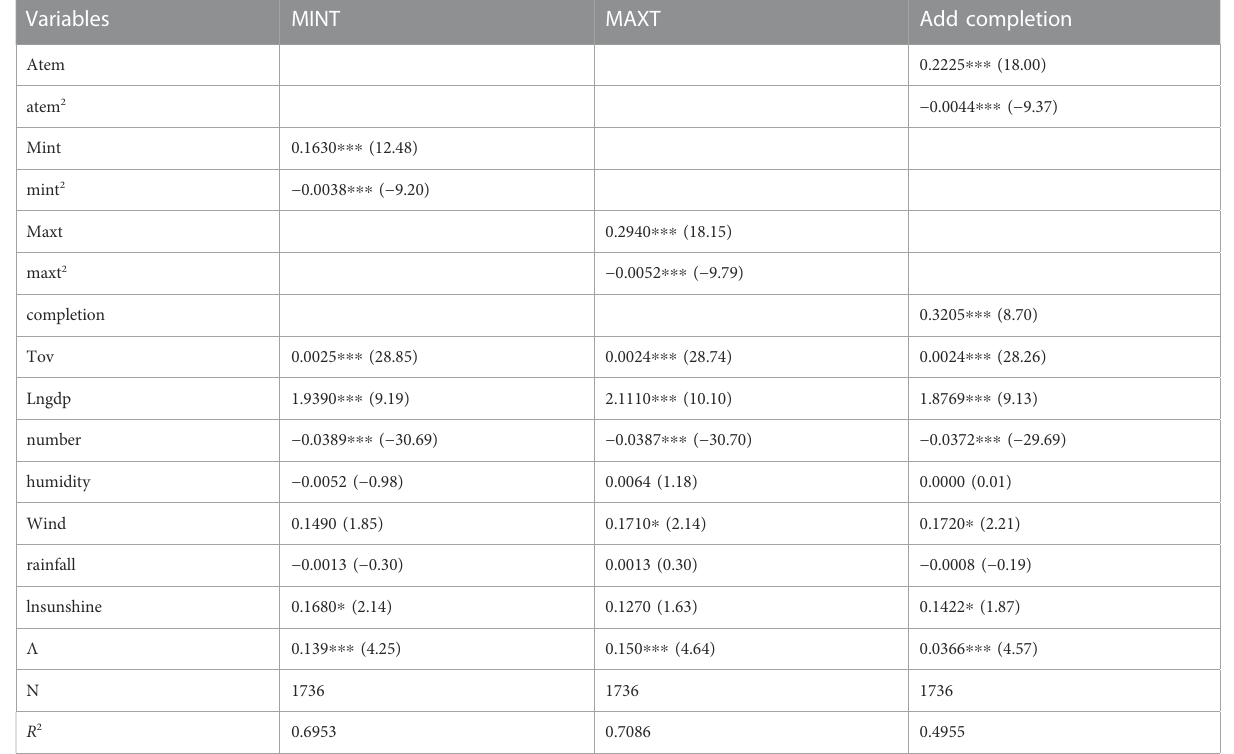
TABLE 6 Results for robustness